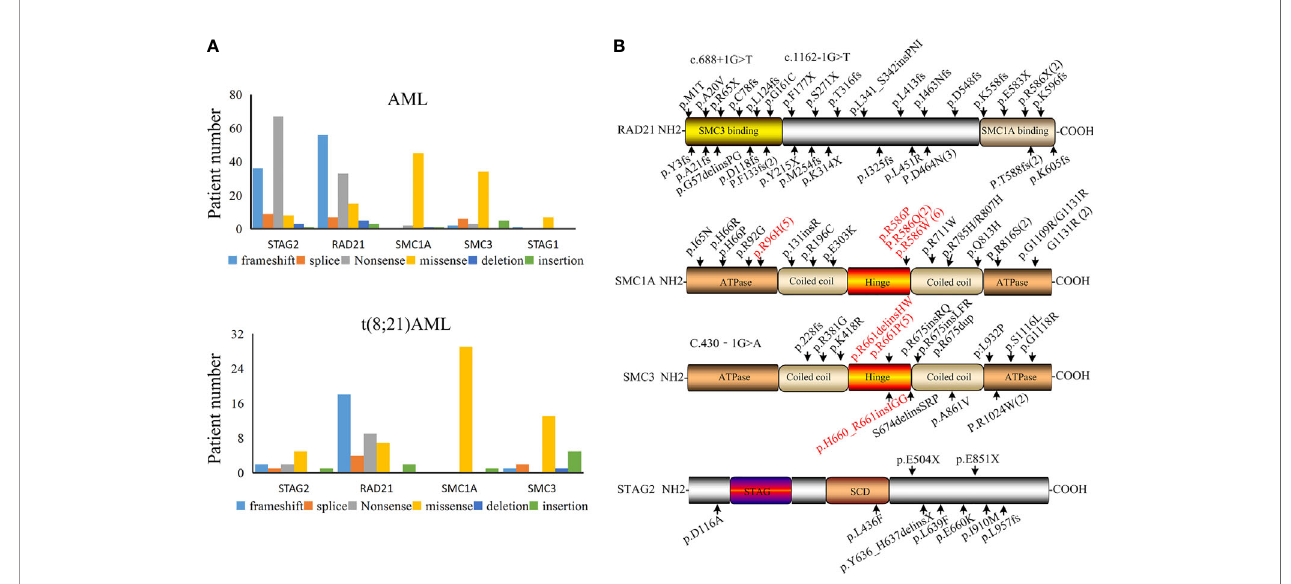
FIGURE 2 | Cohesin mutation in patients with AML. (A) Various types of cohesin mutations. (B) Location of mutations in the cohesin complex in t(8;21)